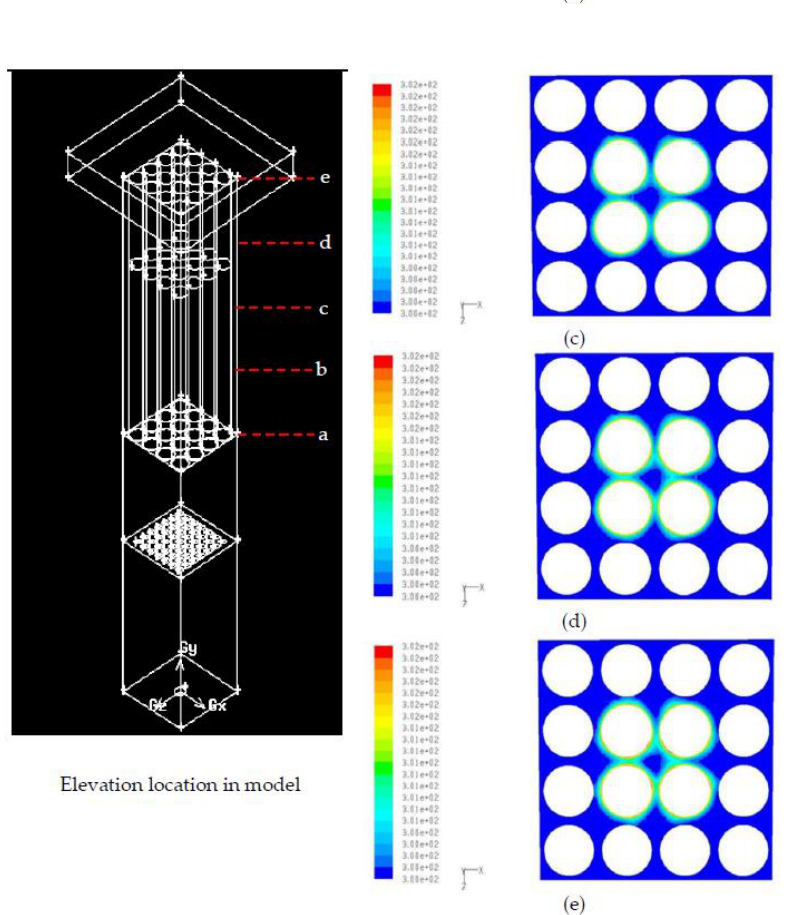
Figure 10. Contour of fluid temperature at various elevations from the fresh water inlet or velocity inlet (( a ) = 0.60 m, ( b ) = 0.70 m, ( c ) = 0.80 m, ( d ) =0.90 m, and ( e ) = 1.0 m).